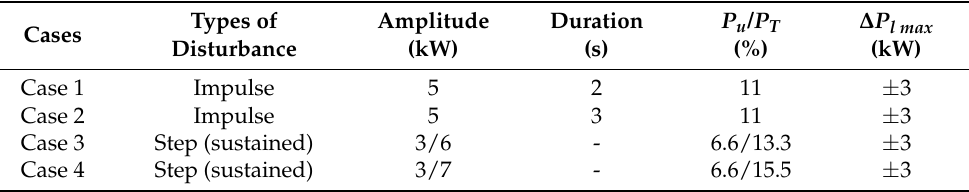
Table 3. Types and magnitudes of simulated